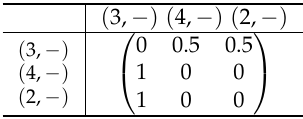
Table 2. Average transition